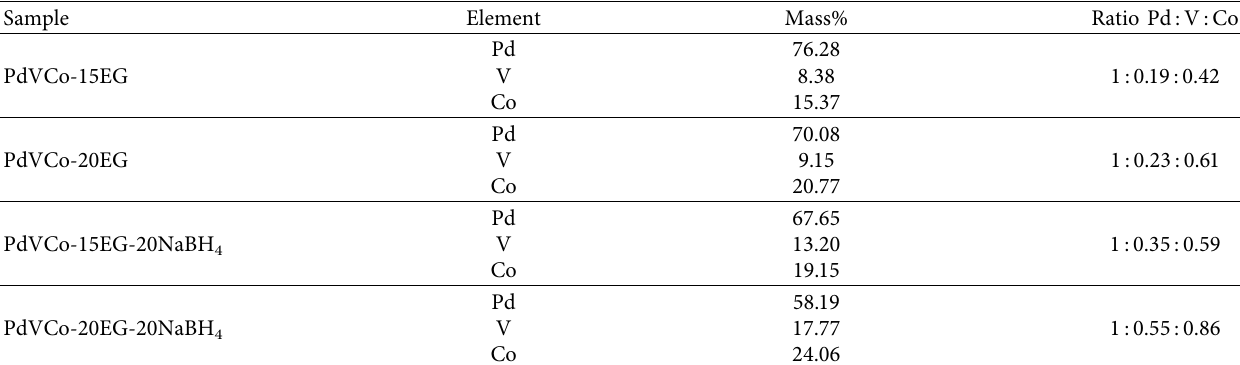
Table 1: Ratio of Pd : V: Co in nanocatalysts.